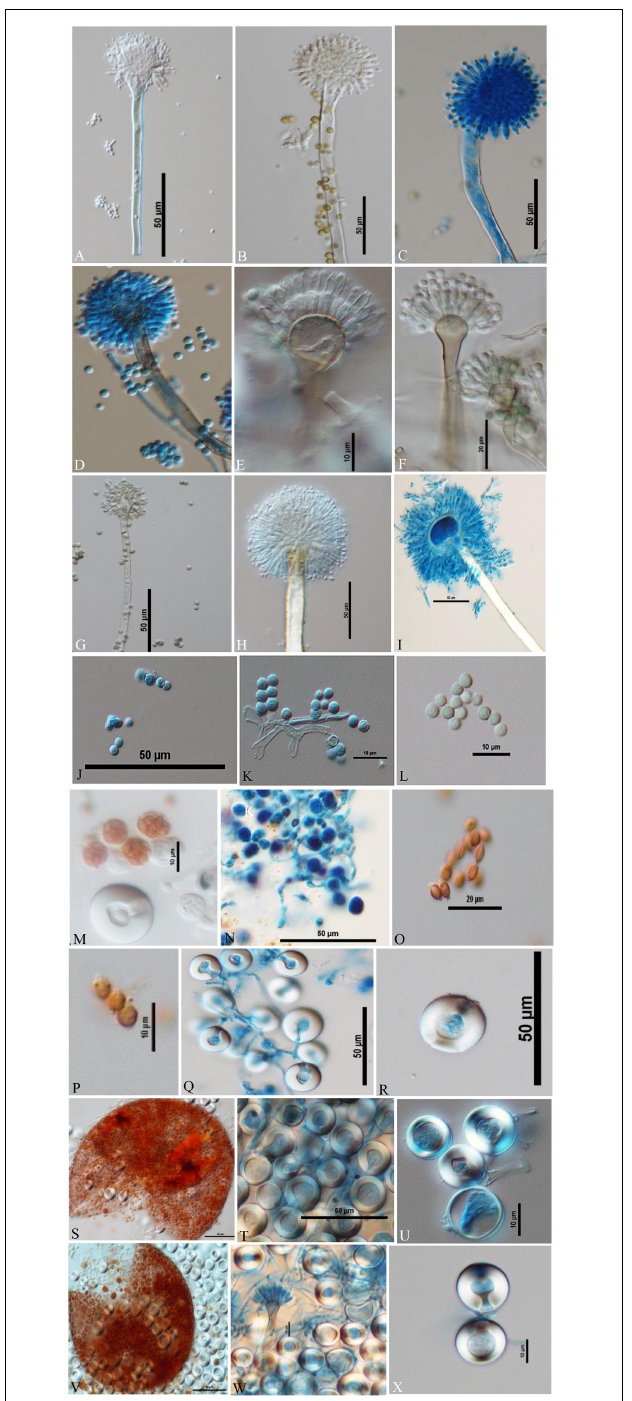
FIGURE 5 | Conidiophores, conidia, asci, ascospores, cleistothecia, and Hülle cells Differential Interference Contrast (DIC) images of Aspergilli (A) A. aureoterreus smooth, long, colourless conidiophores and columnar, biseriate conidial heads with hemispherical vesicles, metulae phialides, and conidia; (B,C) A. tamarii conidiophores containing globose, radiating and rough conidia, globose vesicles with uniseriate sterigmata; (D) A. nidulans smooth-walled, sinuate conidiophores and columnar conidial heads with small